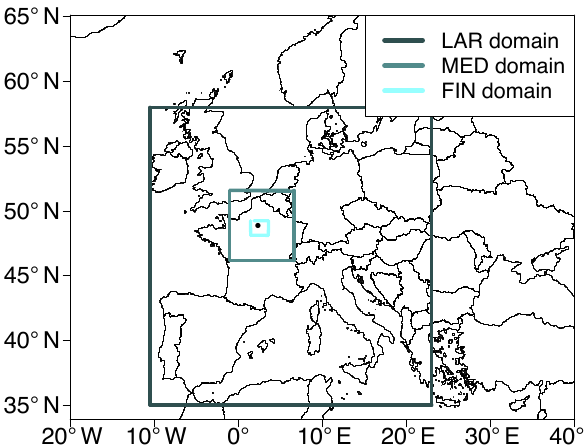
Figure 1. Nested domains (the black points in the finest domain indicates Paris). Resolutions are 0.5 × 0.5 ◦ (LAR domain), 9 × 9km (MED), and 3 × 3